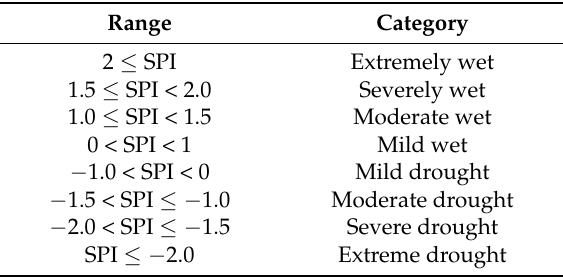
Table 1. SPI classification according to McKee et al.